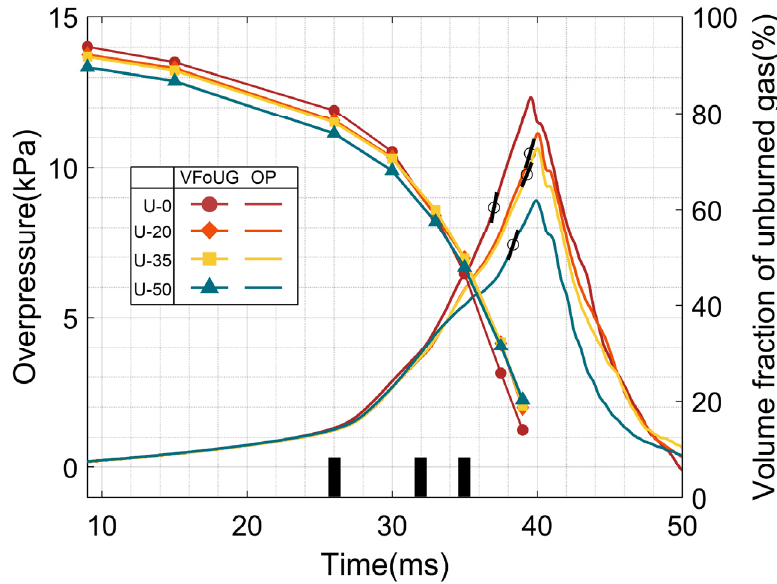
Figure 7. The relation of the volume fraction of unburned premixed gas and pressure.